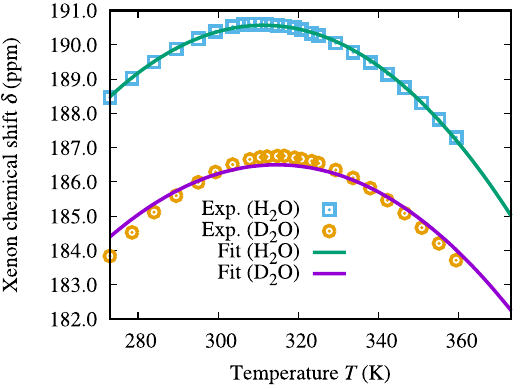
Figure 6. 129 Xe chemical shift in an aqueous D 2 O/H 2 O solution of atomic xenon in the semianalytical cavity model, fitted to experiment.